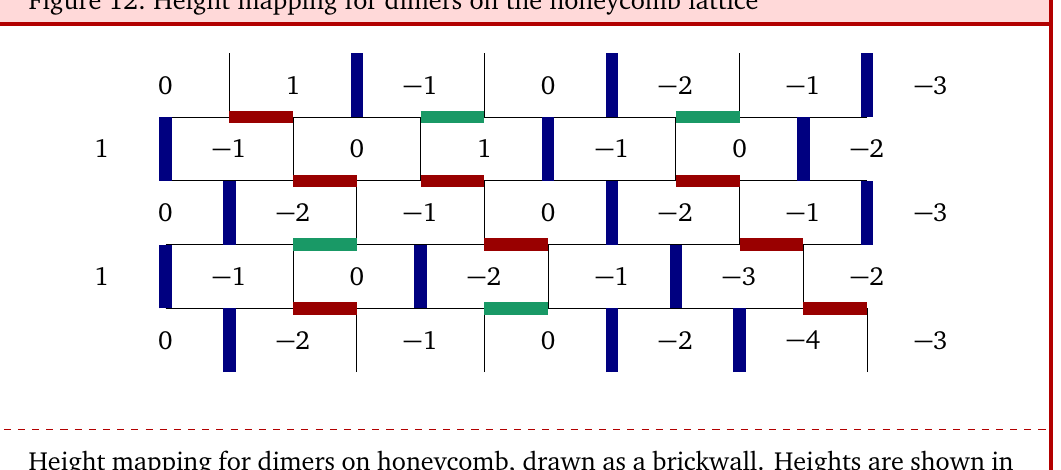
Height mapping for dimers on honeycomb, drawn as a brickwall. Heights are shown in units of π/ 3, as explained in the text. Recall that particles (fermions) are vertical edges not occupied by a